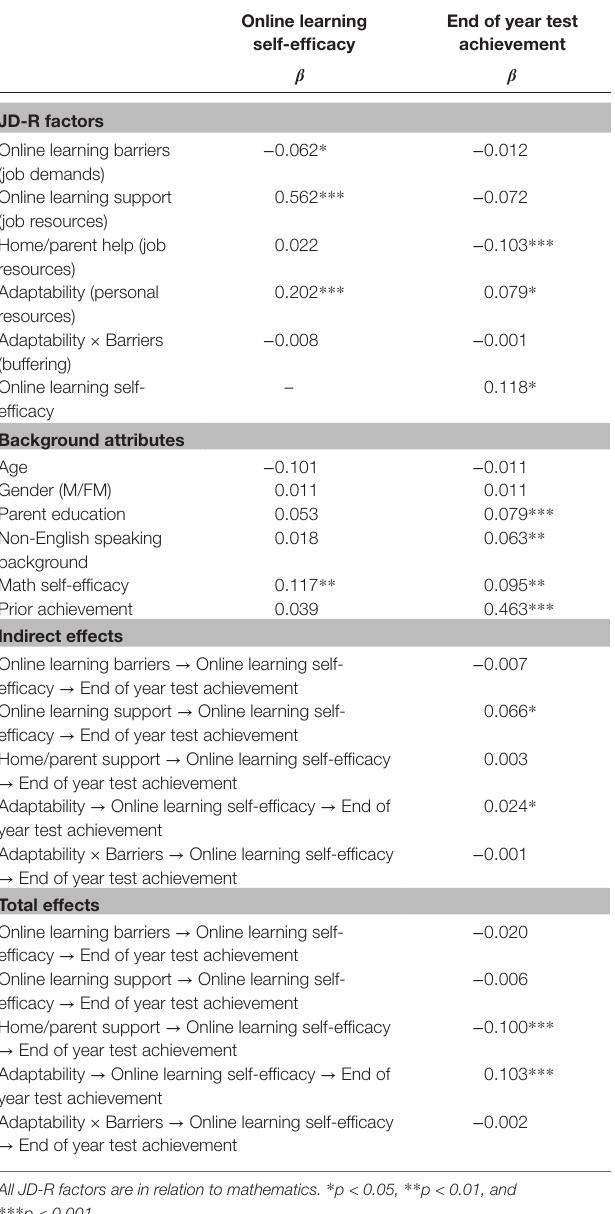
TABLE 3 | Standardized direct and indirect effects for JD-R process in online mathematics. Online learning